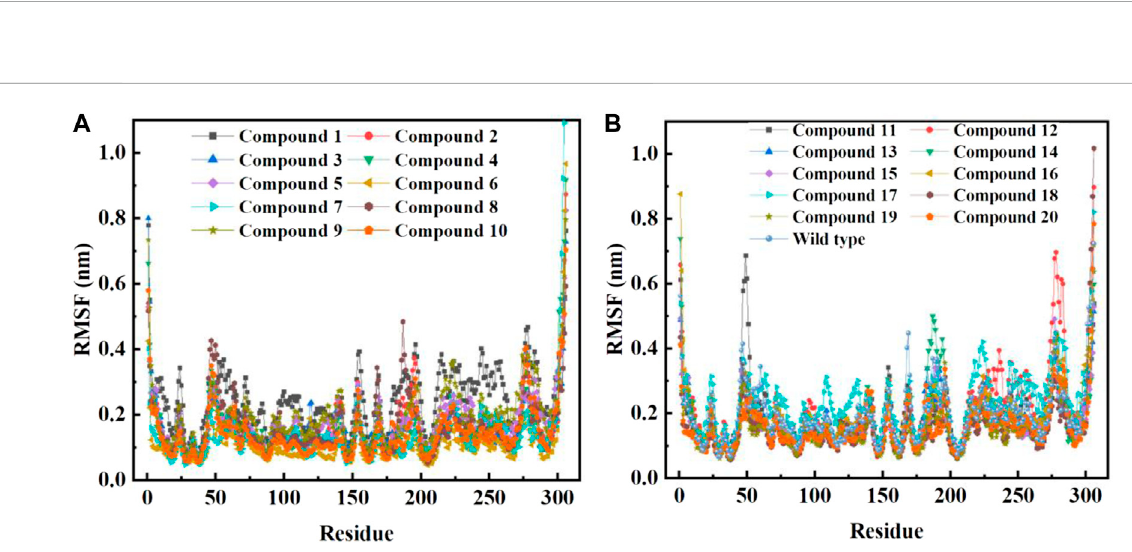
FIGURE 10 RMSFperresidueofbackboneC-alphaatomsofCOVID-19M pro relativetothestartingcomplexesatdifferentligandsystemsorwildM pro during 200 ns MD